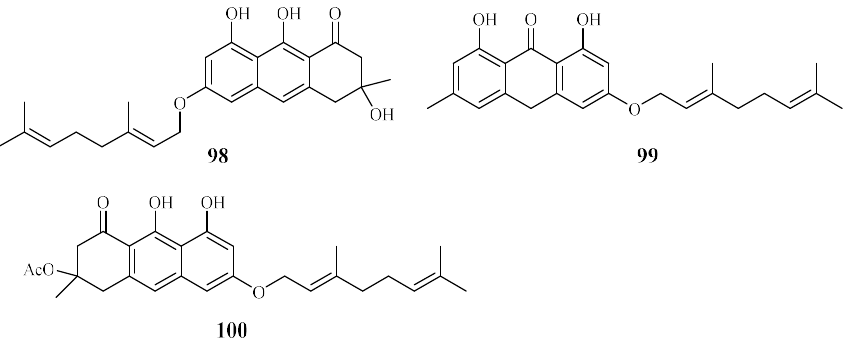
Figure 19. Compounds from Hypericaceae plants.